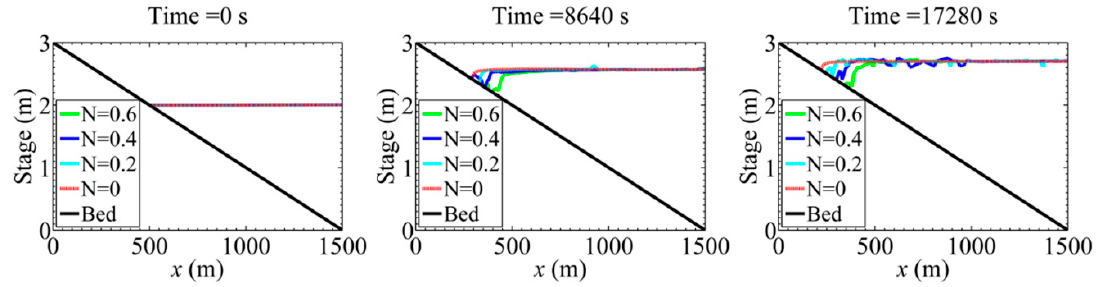
Figure 5. Effect of ice concentrations on the surge run-up in the beach at times: 0 s, 8640 s, and 17,280 s.